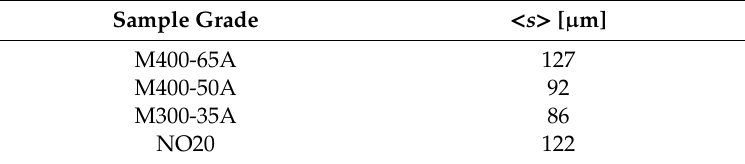
Table 4. Average grain size < s > for the investigated non-oriented alloys. Sample